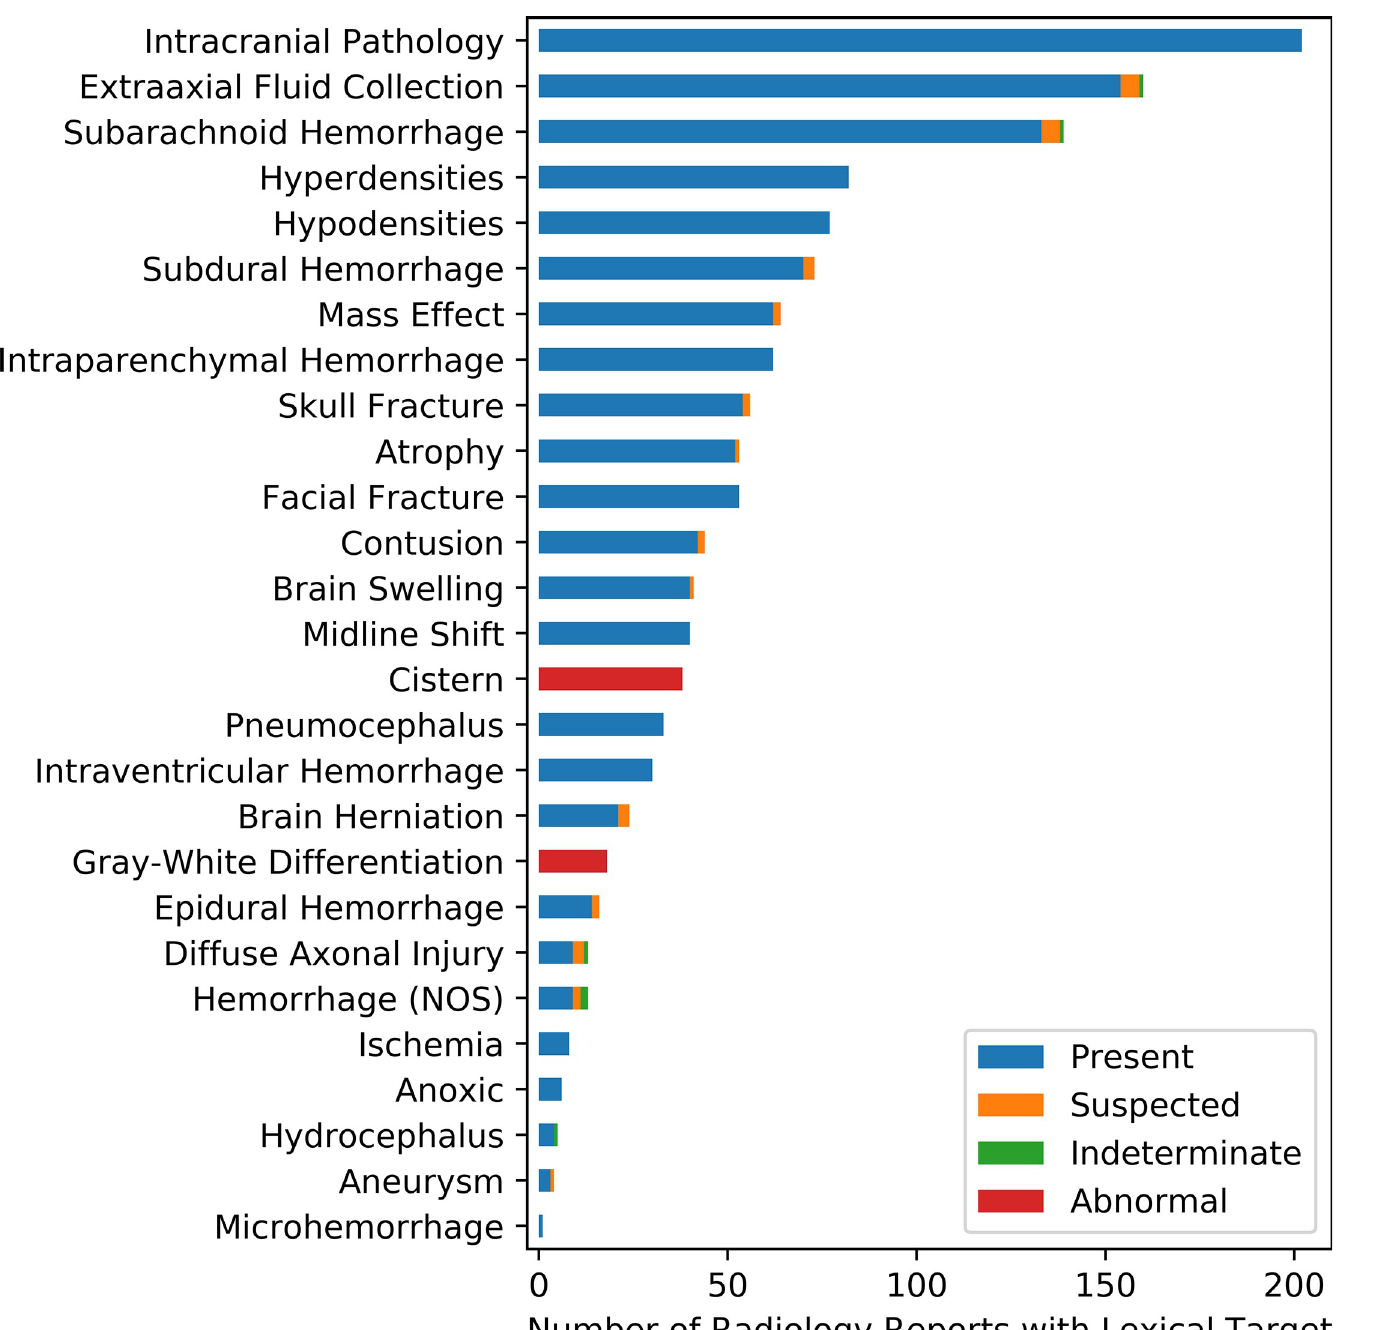
Fig 5. tbiExtractor output annotations. tbiExtractor output annotations for the 27 selected lexical targets over the entire corpus (N = 417 radiology reports).